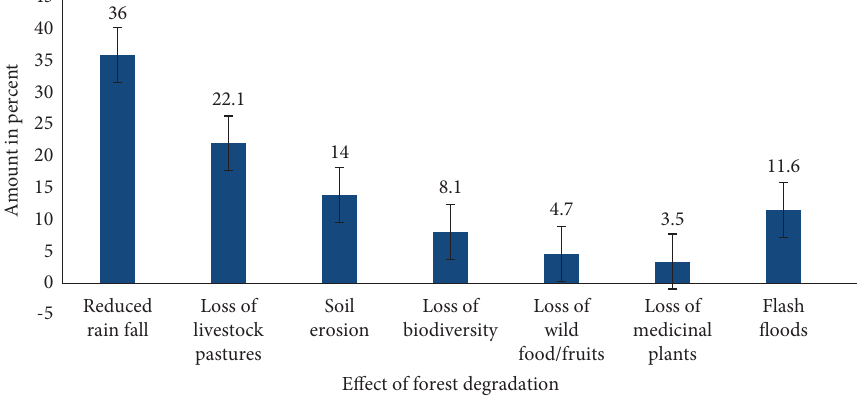
Figure 6: Negative impacts of deforestation in Ofa Woreda. source: feld survey result